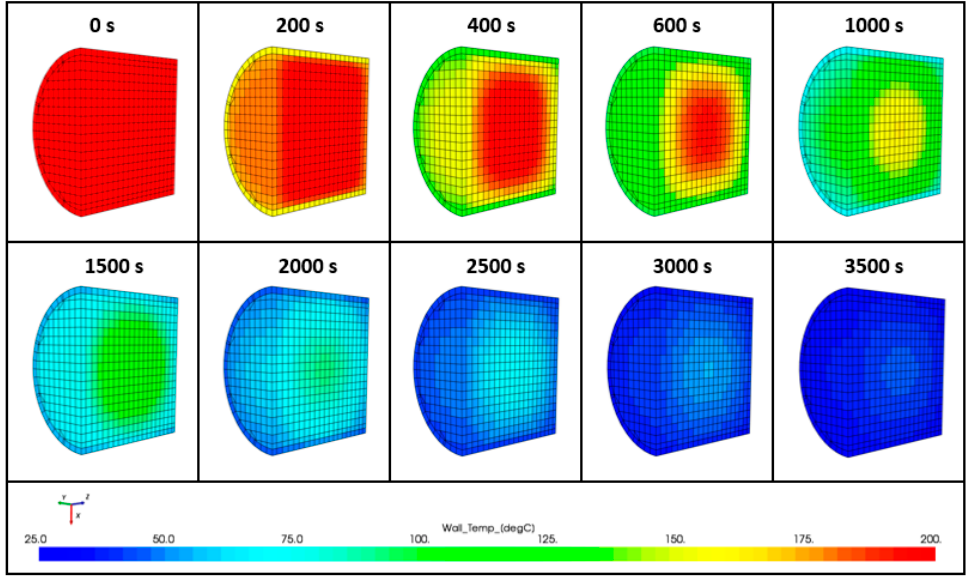
Figure 10. Evolution of monolith’s 3D thermal field during cooling down under zero-flow condi- tions.